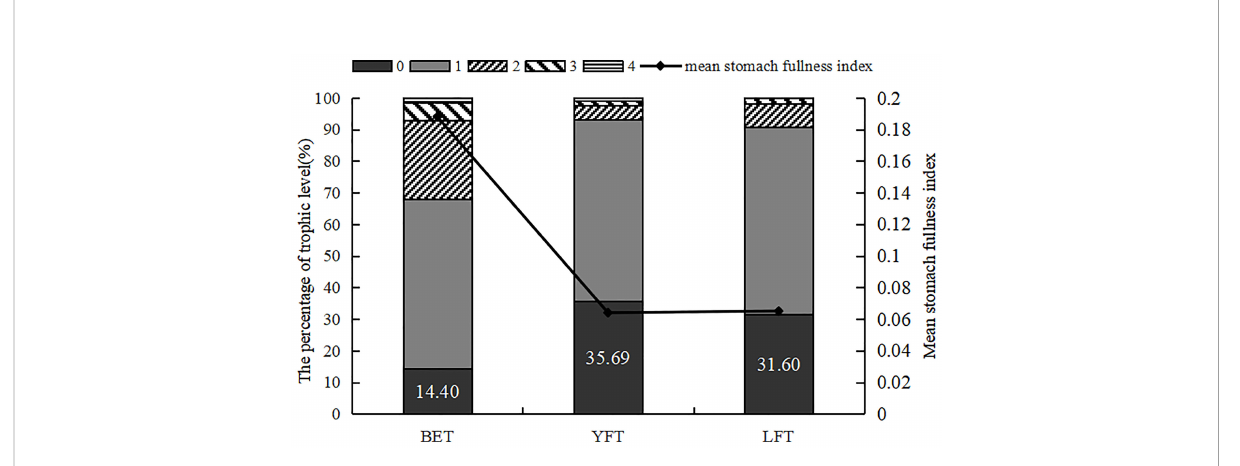
FIGURE 2 The percentage of trophic level and mean stomach fullness index of three species of tuna. BET, big eye tuna, Thunnus obesus ; YFT, yellow fi n tuna, T. albacares ; LFT, albacore tuna, T. alalunga